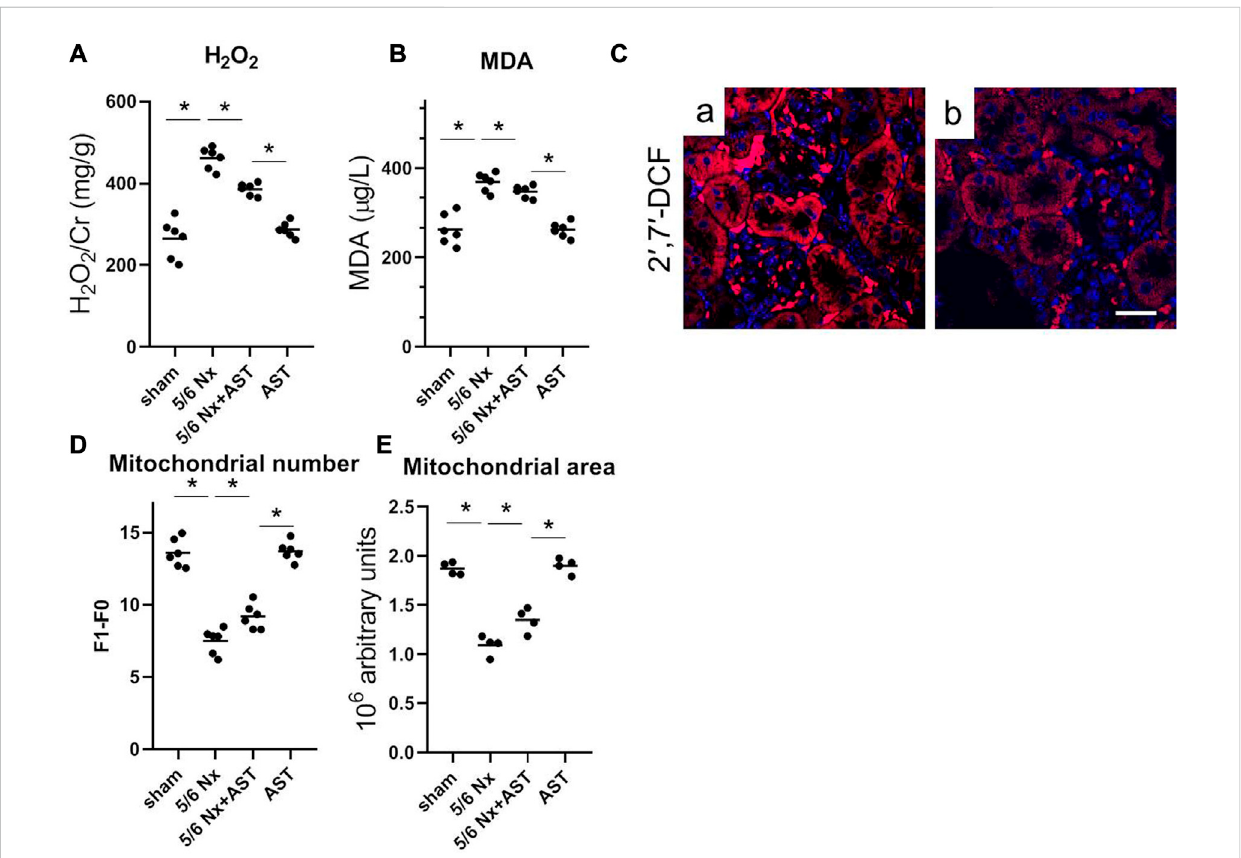
FIGURE 5 AST reduced 1-deoxySL-induced oxidative stress in 5/6 Nx rats. Quantitative analysis of (A) urinary H2O2 and (B) serum MDA from rats in sham, 5/ 6 Nx, 5/6 Nx + AST and AST groups. n = 6/group. The data shown are means ± SD, one-way ANOVA with Bonferroni ’ s test. (C) Representative images showing oxidative stress with 2 ′ ,7 ′ -DCF staining on the fresh renal sections from (a) 5/6 Nx and (b) 5/6 Nx + AST groups (scale bar 50 μ m). Quantitative analysisofelectronmicroscopyimagesof (D) mitochondrialnumberand (E) mitochondrialarea.n=6mice/group.Thedatashownaremeans±SD, one-way ANOVA with Bonferroni ’ s test. * p <